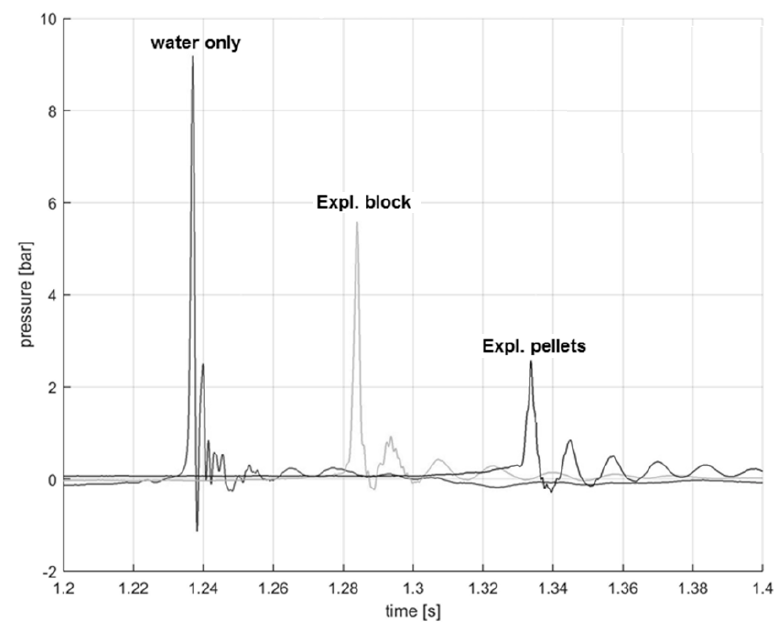
Figure 14. Pressure peaks recorded next to the tank impacted wall (pressure sensor P1) during perforation with steel spheres of different size (between 9.55 and 14 mm diameter).